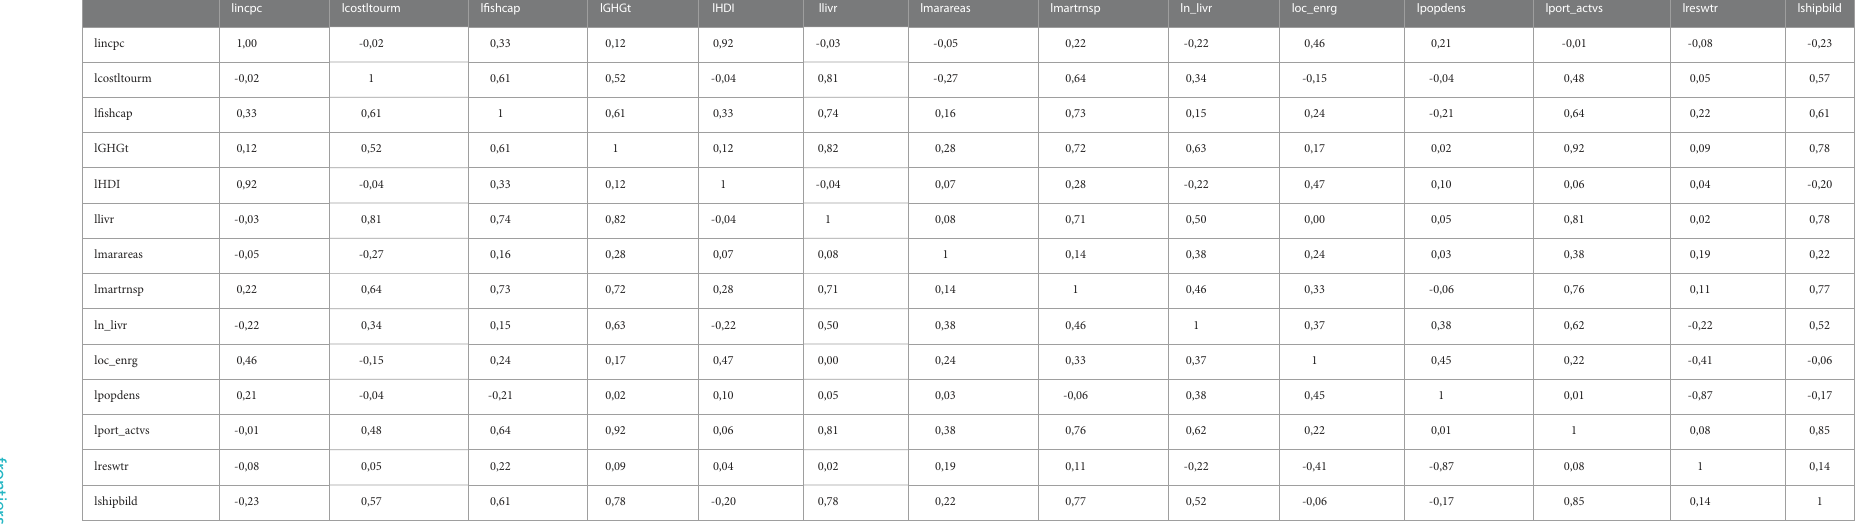
TABLE 2 Correlation